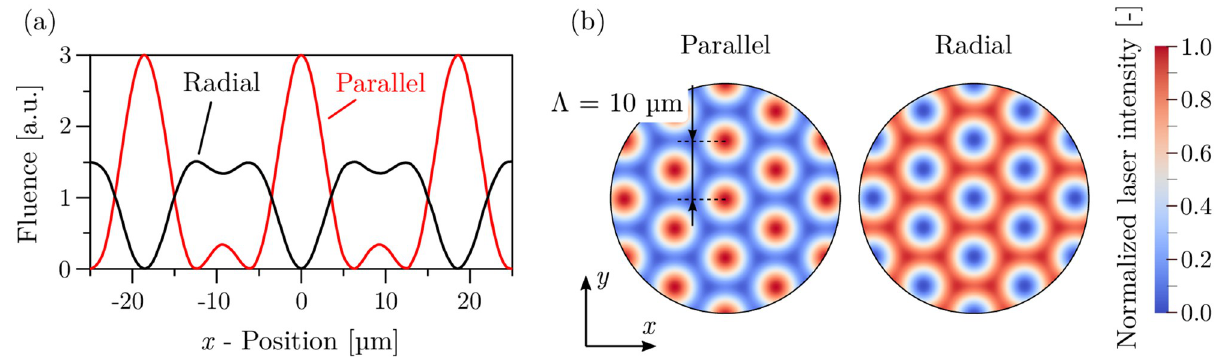
Fig 2. Laser interference pattern formed with parallel and radial distribution of polarization vectors: (a) Cross-section of the fluence profiles according to Voisiat et al. [25]; (b) normalized laser intensity at the interface as input for the volumetric laser heat source.